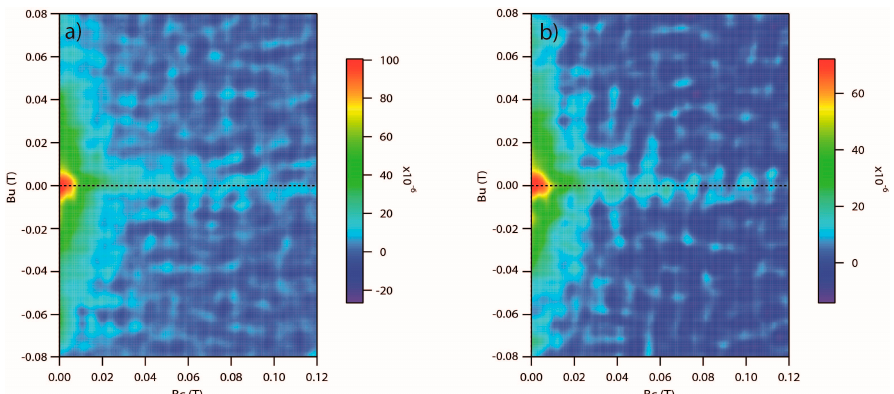
Figure 5. FORC (First Order Reversal Curve) diagrams for samples 11 ( a ) and 20 ( b ); the smoothing factor was 5 and 4, respectively.